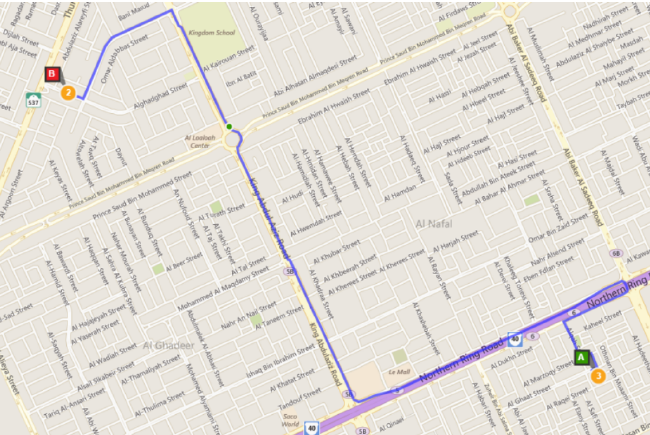
Figure 8. The usual routing between A and B .